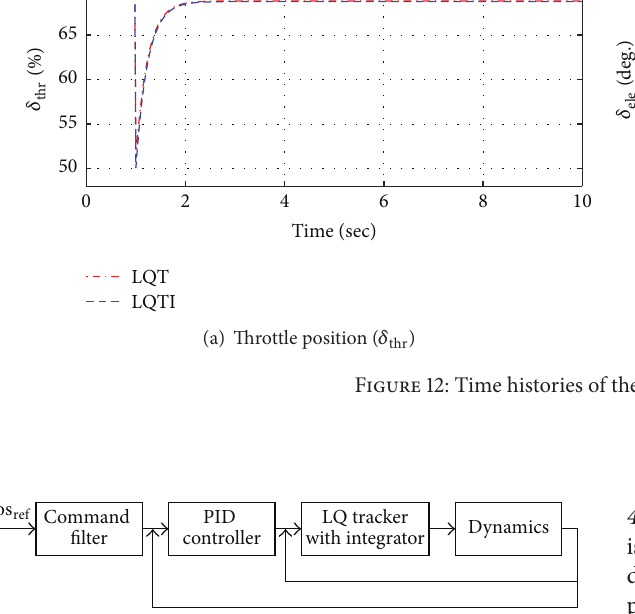
Figure 13: Control system of the CNU ducted-fan